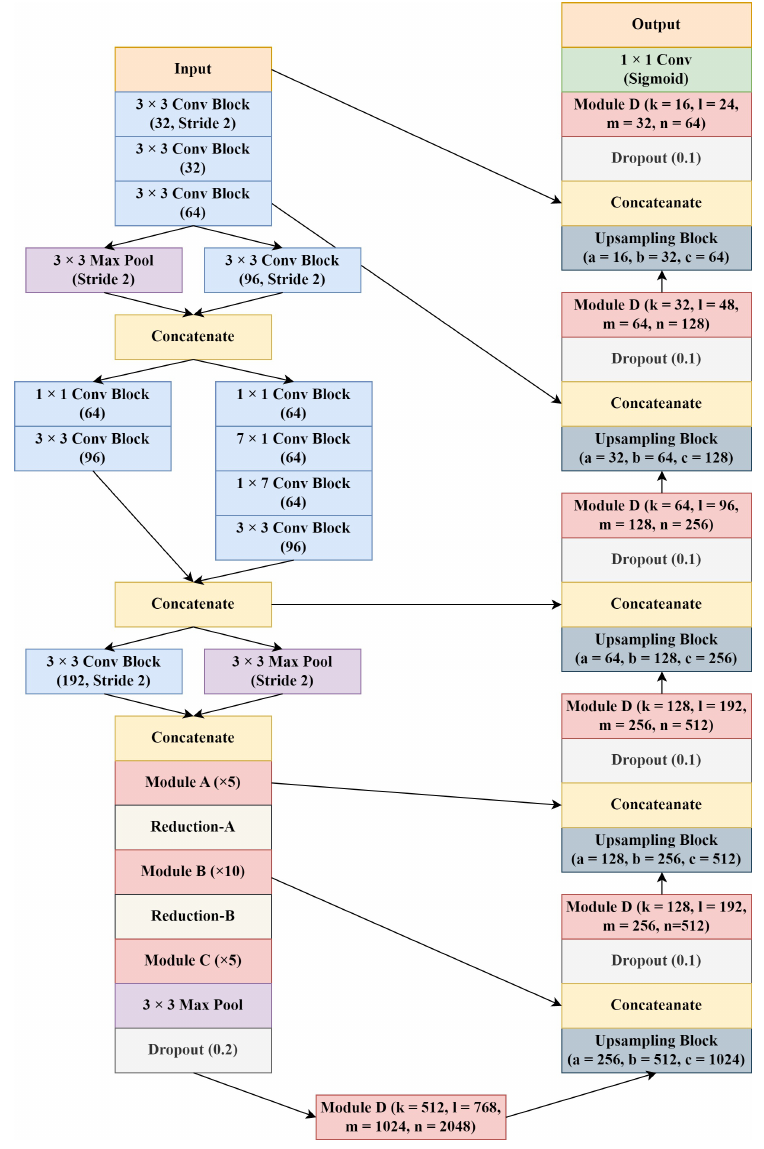
Figure 4. Overall architecture of the